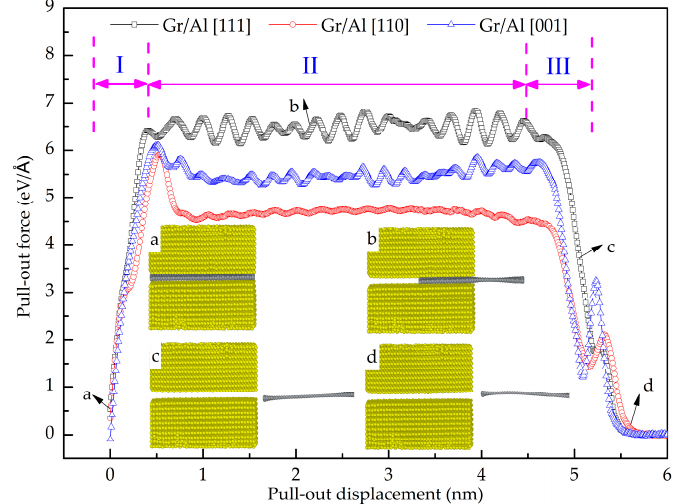
Figure 7. Pull-out force as a function of displacement with different Al crystal orientations. Nanomaterials 2018 , 8 , x FOR PEER REVIEW